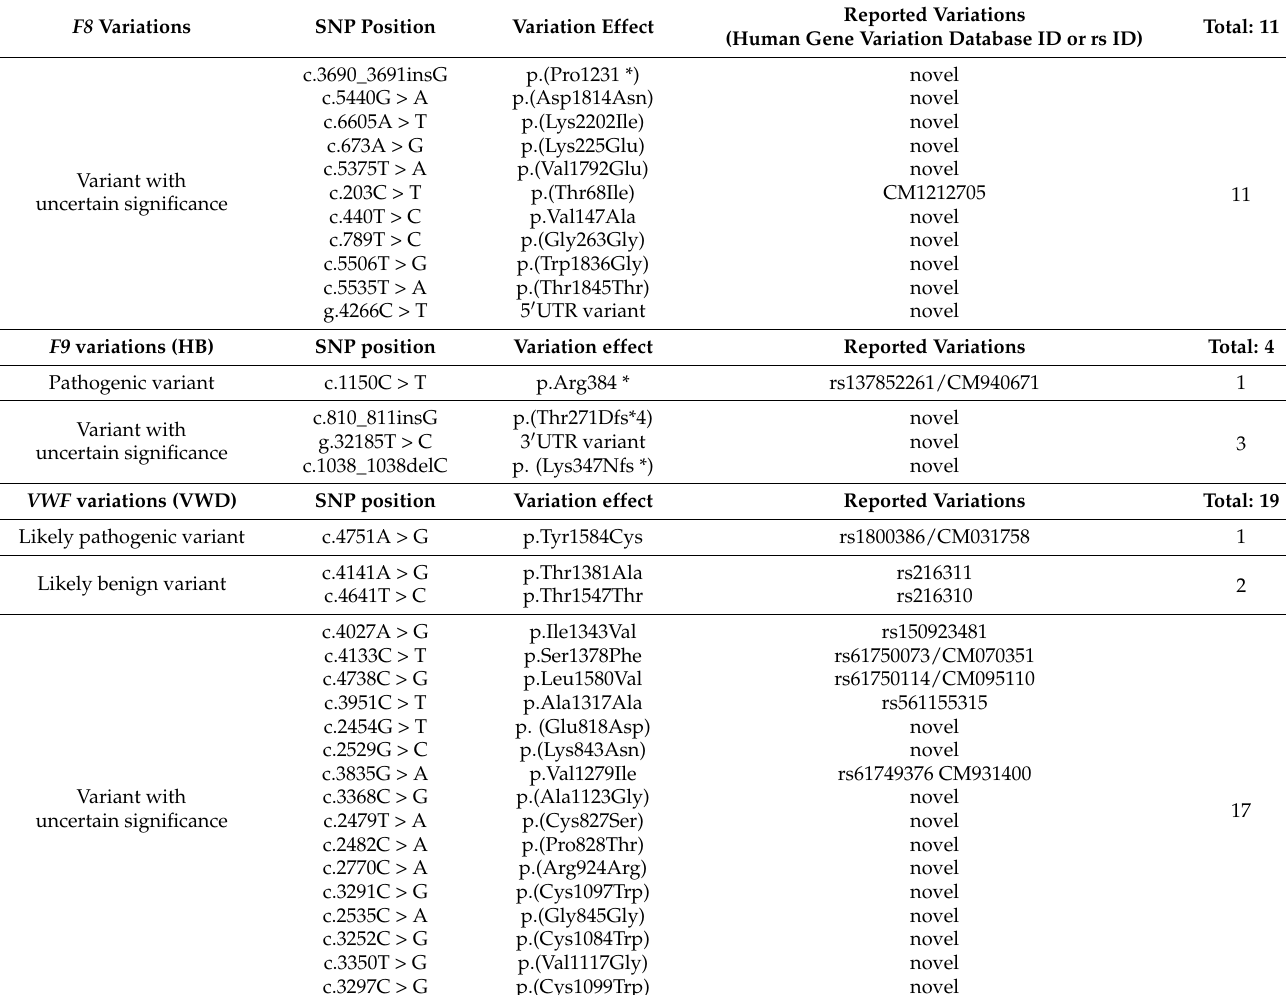
Figure 1. PCR test for the F8 int1h-related inversion. Lane 1 corresponds to 1Kb ladder. Lane 2: Negative control. Amplification products for HA patients from HA1 to HA11 (Lanes 3 to 13). Amplification products for 2 healthy subjects (Lanes 15 and 16). Table 3. Classification of variations in patients with HA, HB, or VWD according to the clinical